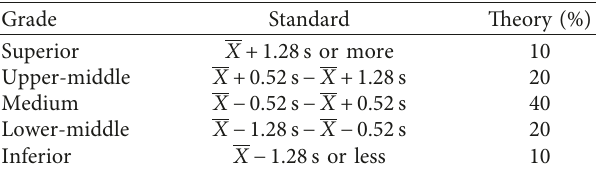
Table 3: Comprehensive evaluation criteria for special physical fitness indicators.